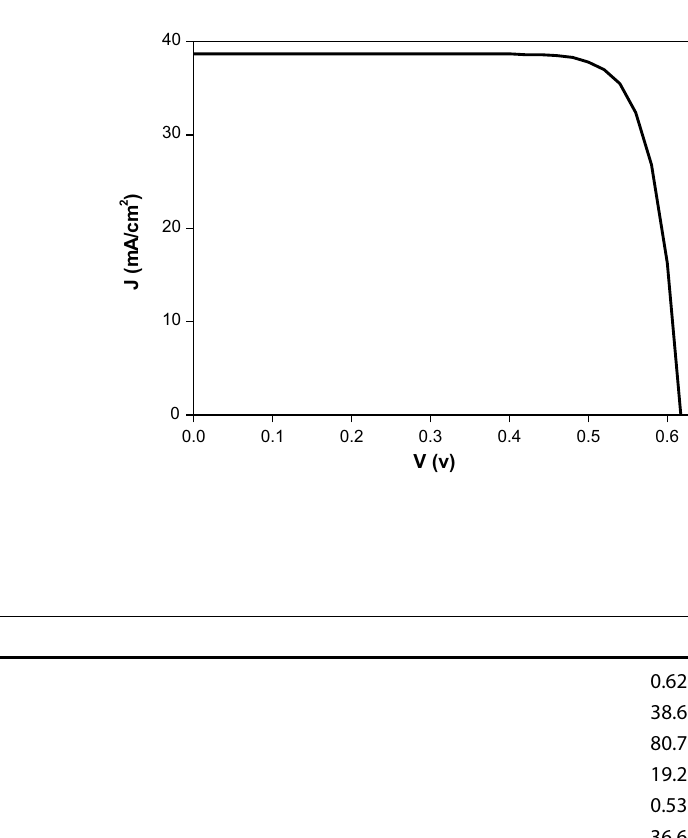
Fig. 3 J–V characteristics of MoSe solar cells 2